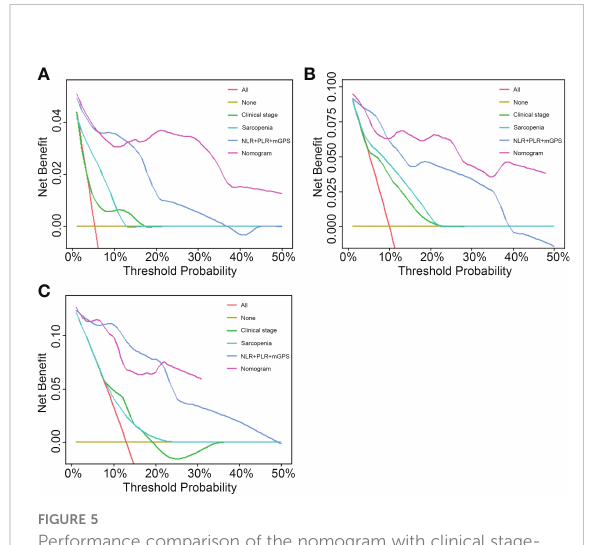
FIGURE 5 Performance comparison of the nomogram with clinical stage- based, sarcopenia-based and integrated “ NLR+PLR+mGPS ” methods. (A) 1-year decision curve analysis of the four models. (B) 2-year decision curve analysis of the four models. (C) 3-year decision curve analysis of the four models. NLR, neutrophil-to- lymphocyte ratio; PLR, platelet-to-lymphocyte ratio; mGPS, modi fi ed Glasgow Prognostic